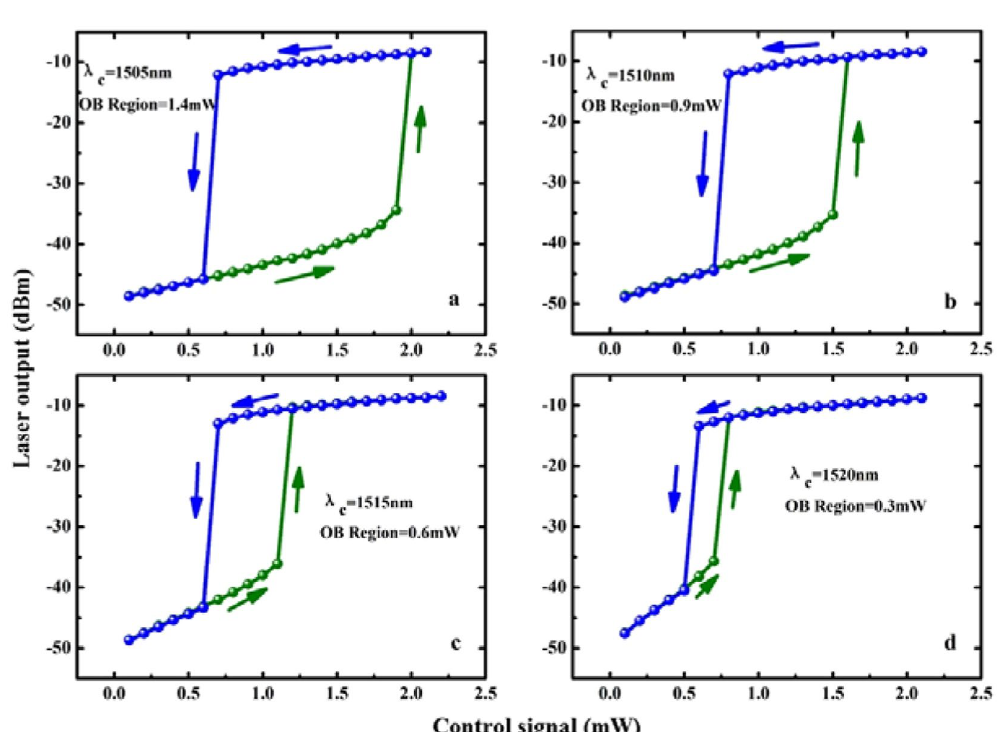
Figure 2. Laser Output power versus control signal for different wavelengths of control